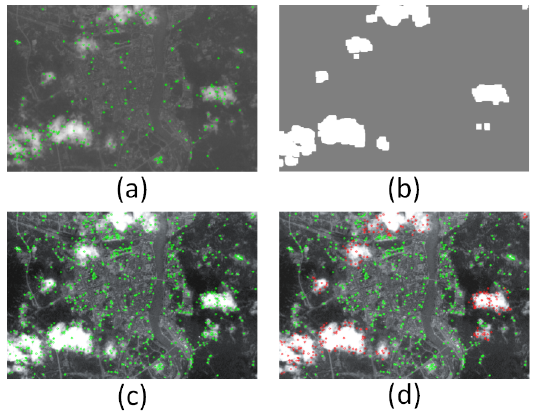
Figure 3. Results of the coarse stage. (a) Features extracted on the raw image. (b) Cloud mask of (a). (c) Features extracted on the stretched image using Eq.2. (d) Filtered result of (c) based on cloud mask (b) and RANSAC. Red and green points indicate cloud contour and ground points